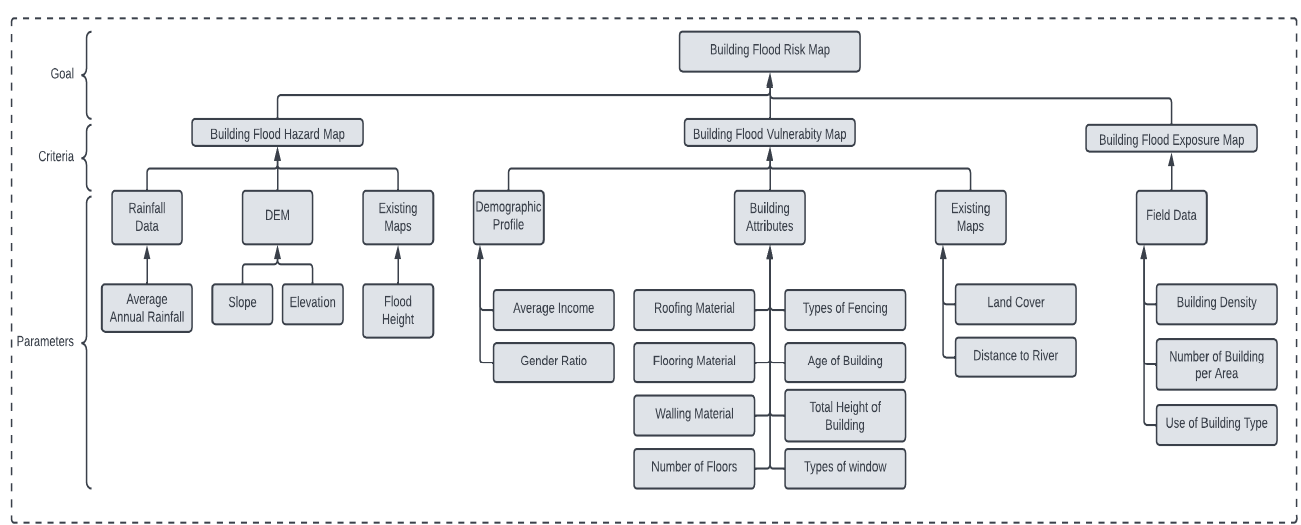
Figure 6. Hierarchy tree for AHP framework for building flood risk analysis.